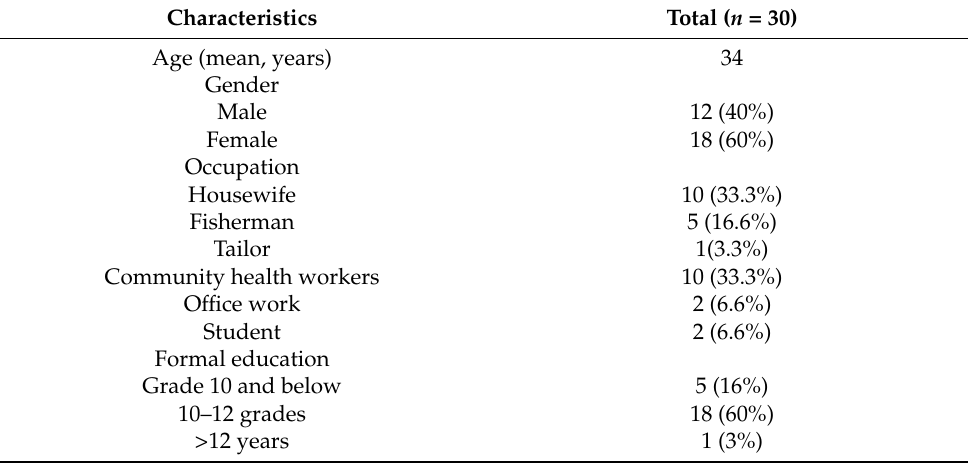
Table 1. Demographic characteristics of the participants from